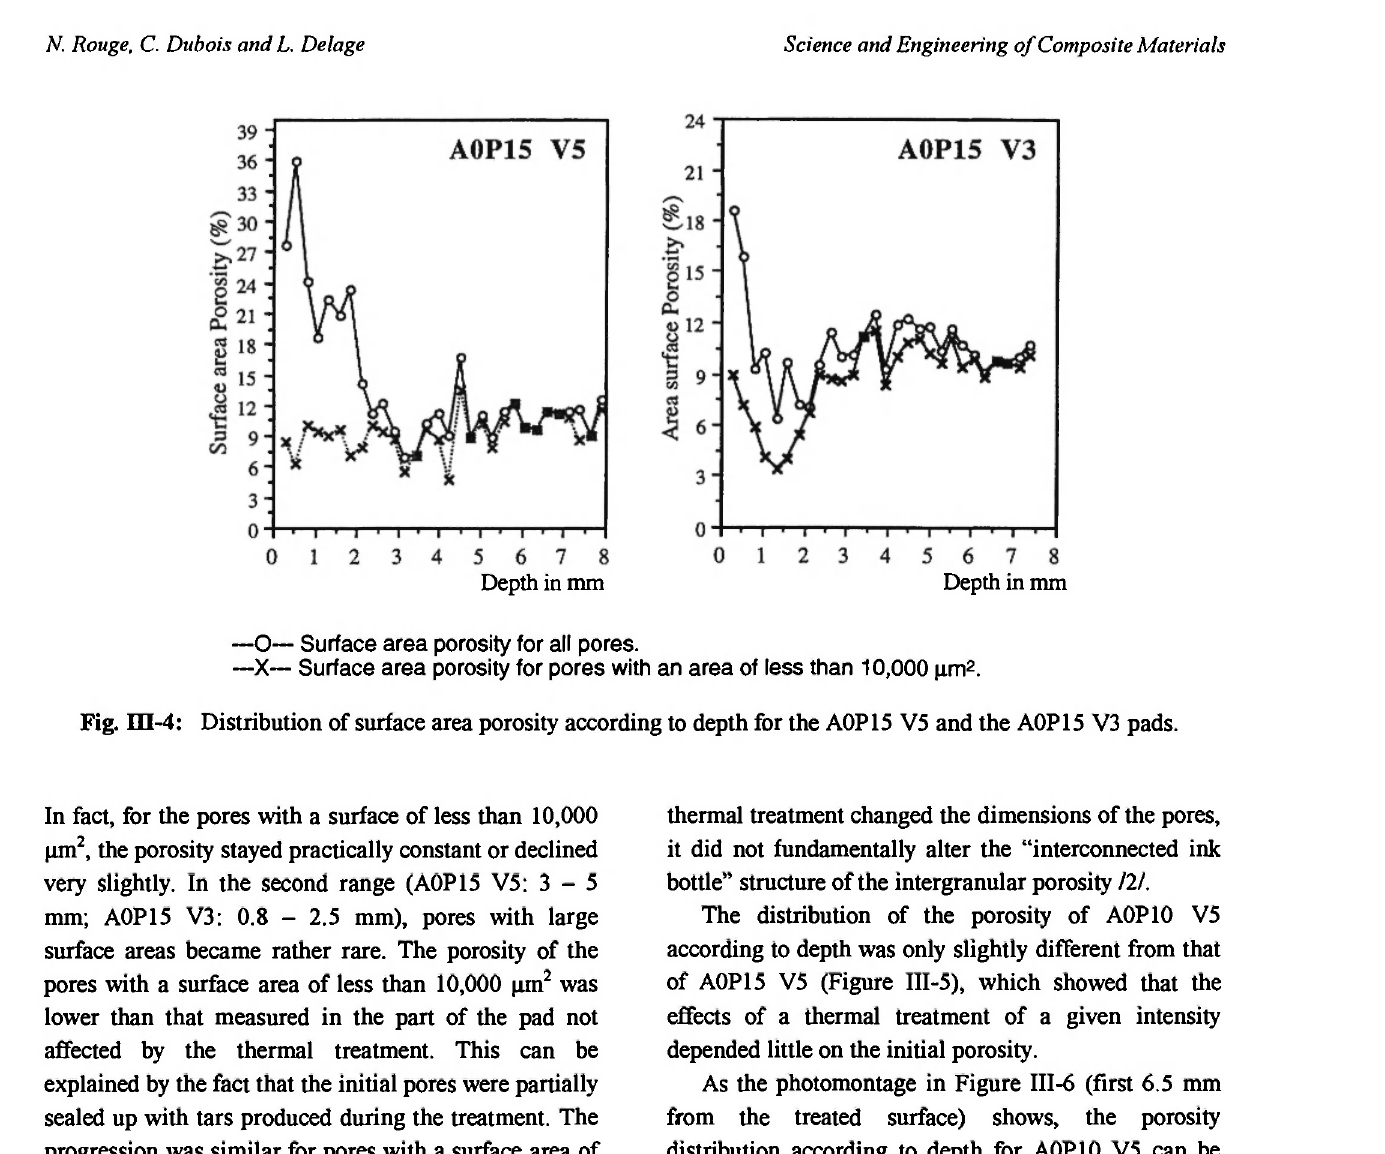
Fig. ΠΙ-4: Distribution of surface area porosity according to depth for the A0P15 V5 and the A0P15 V3 pads. In fact, for the pores with a surface of less than 10,000 μτη 2 , the porosity stayed practically constant or declined very slightly. In the second range (A0P15 V5: 3 - 5 mm; A0P15 V3: 0.8 - 2.5 mm), pores with large surface areas became rather rare. The porosity of the pores with a surface area of less than 10,000 μιη 2 was lower than that measured in the part of the pad not affected by the thermal treatment. This can be explained by the fact that the initial pores were partially sealed up with tars produced during the treatment. The progression was similar for pores with a surface area of less than 10,000 μηι 2 in the first range, but in this case, this was due to the fact that large pores were created in part to the detriment of smaller